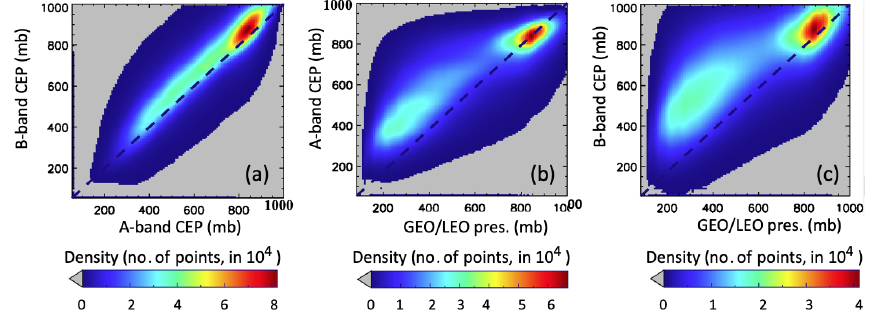
Figure 9. EPIC A- and B-band CEP and the comparison with cloud pressure from GEO–LEO composites. Data used are the same as in Fig. 7. Scatterplots (a) for EPIC A- vs. B-band CEP, (b) the GEO–LEO composites cloud pressure vs. EPIC A-band CEP, and (c) the GEO–LEO composites cloud pressure vs. EPIC B-band CEP.